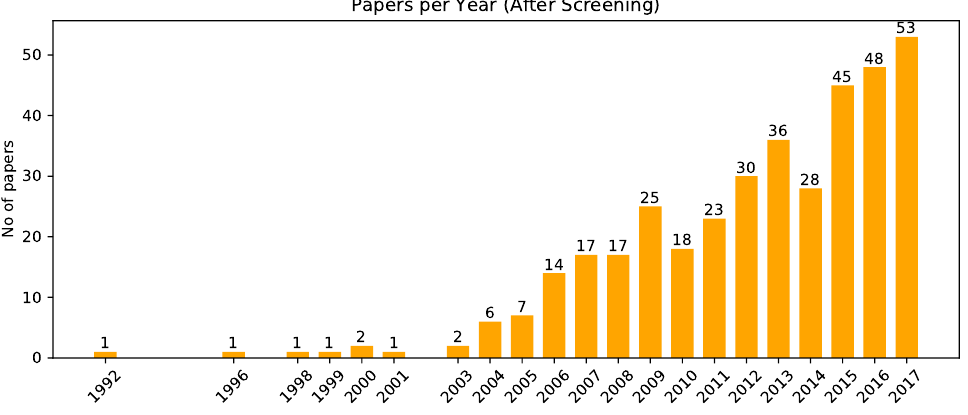
Figure 1. Distribution of papers per Year.